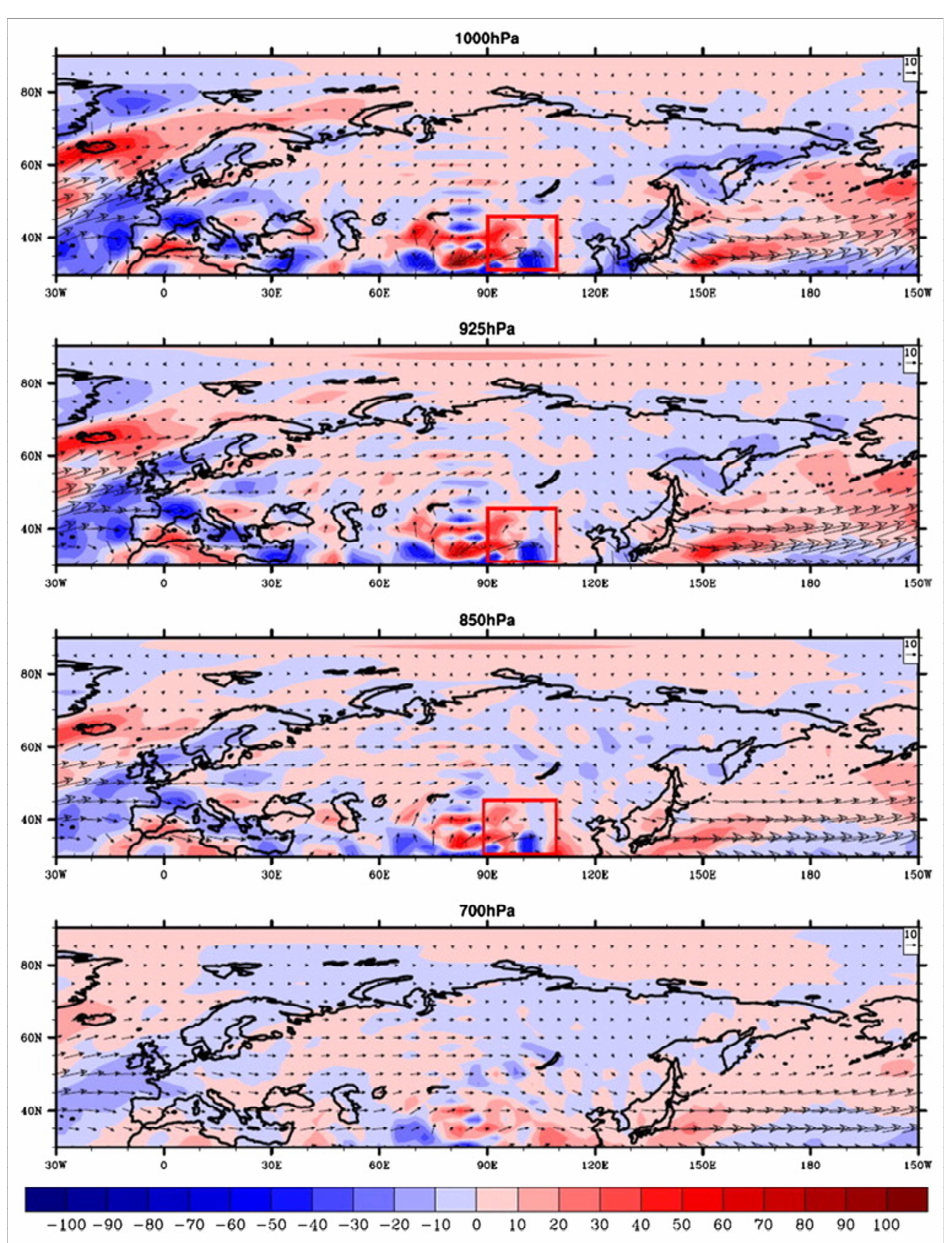
Figure 10. The modeling of moisture supplement on the Alashan Plateau (the red box in the figure) during winter (November, December, January, and February) from AD 1948 to 2009 based on the NCEP (National Centers for Environmental Prediction) (revised from [14]). The arrows in the figures represent moisture delivery capacity, and the negative blue color represents the convergence current and the positive red color represents the divergence current. The air pressures of 100, 925, 850, and 700 hPa represent the altitudes of near ground at 600, 1500, and 3000 m, respectively. Moisture is mainly supplied from the southwest red area in the Qilian Mountains below an altitude of 3000